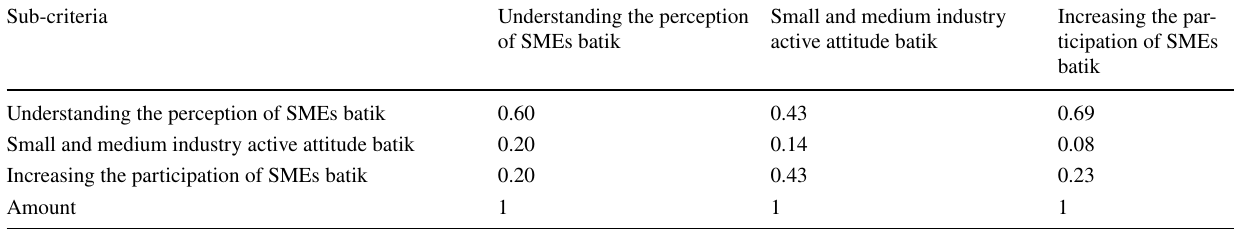
Table 9 Sub-criteria comparison matrix normalization Sub-criteria